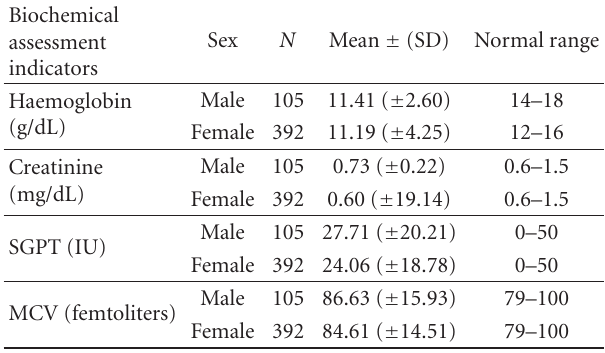
Table 5: Distribution of HIV sero-positive patients by biochemical indicators and sex.